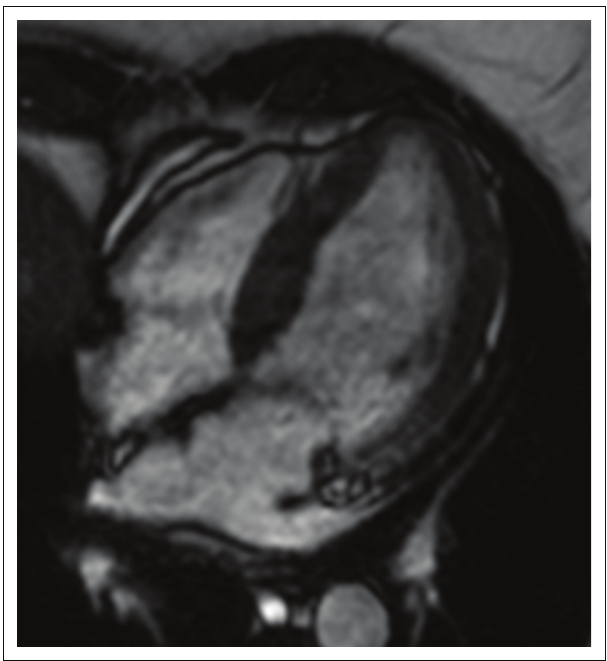
FIGURE 5: Hypertrophic cardiomyopathy. Four-chamber end-diastole cine b-SSFP image demonstrating a thickened septum and LV lateral Figure 5 and Figure 6 demonstrate the imaging features of HCM.